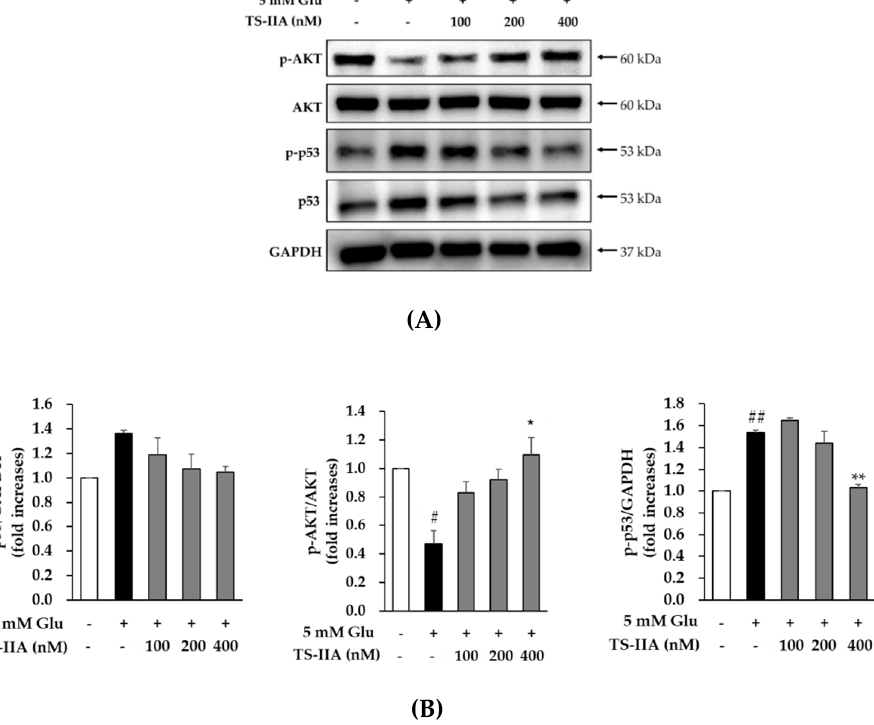
Figure 5. The protective e ff ect of tanshinone IIA (TS-IIA) against glutamate-induced apoptosis in HT-22 cells occurred through the activation of Akt, which led to the inhibition of p53 activation and phosphorylation. ( A ) HT-22 cells were exposed to 100, 200, or 400 nM TS-IIA in the presence or absence of 5 mM glutamate for 12 h, and analyzed immunoblotting to determine immunoreactive bands for p-Akt, Akt, p-p53, p53, and GAPDH. ( B ) The bar chart described the fold-increase in the phosphorylation of Akt and p53, together with p53 in the control ( N = 2). Notes: # p < 0.05 and ## p < 0.01 compared with the untreated group, * p < 0.05 and ** p < 0.01 compared with the glutamate-treated group (TS-IIA: tanshinone IIA, Glu: